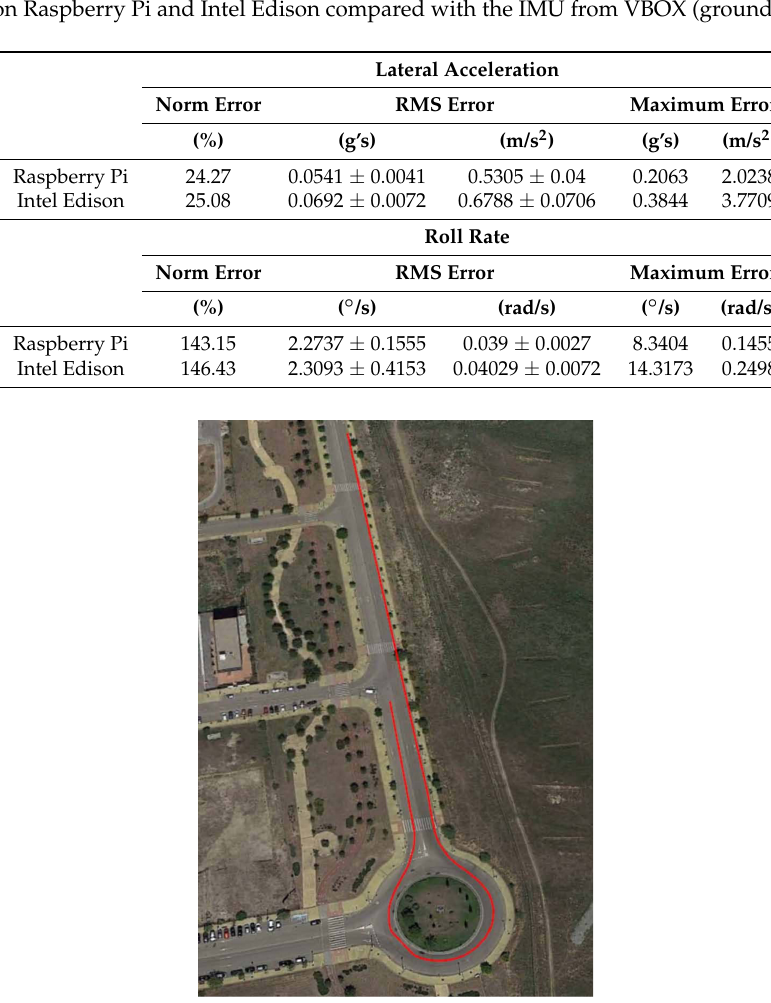
Table 7. Test 1: Errors of lateral acceleration and roll rate data for the accelerometers and gyroscopes mounted on Raspberry Pi and Intel Edison compared with the IMU from VBOX (ground truth).